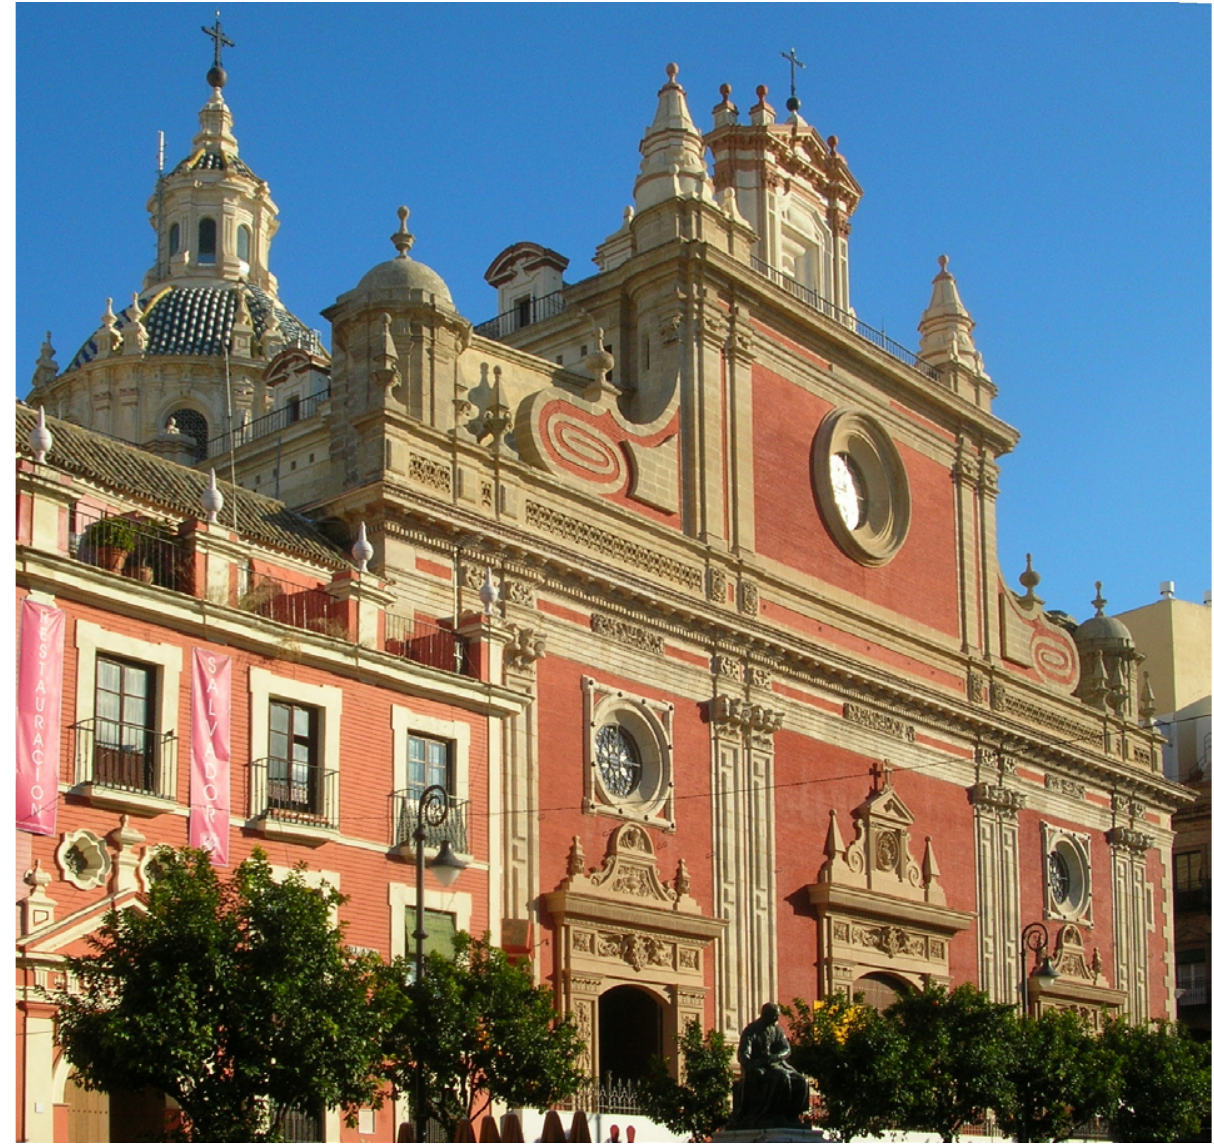
Figure 12: Façade of the ex-collegiate church of El Salvador, Seville. Image from https://www.flickr.com/photos/ james_gordon_losangeles/8295276693/in/photostream/. Copyright James Gordon (Creative Commons